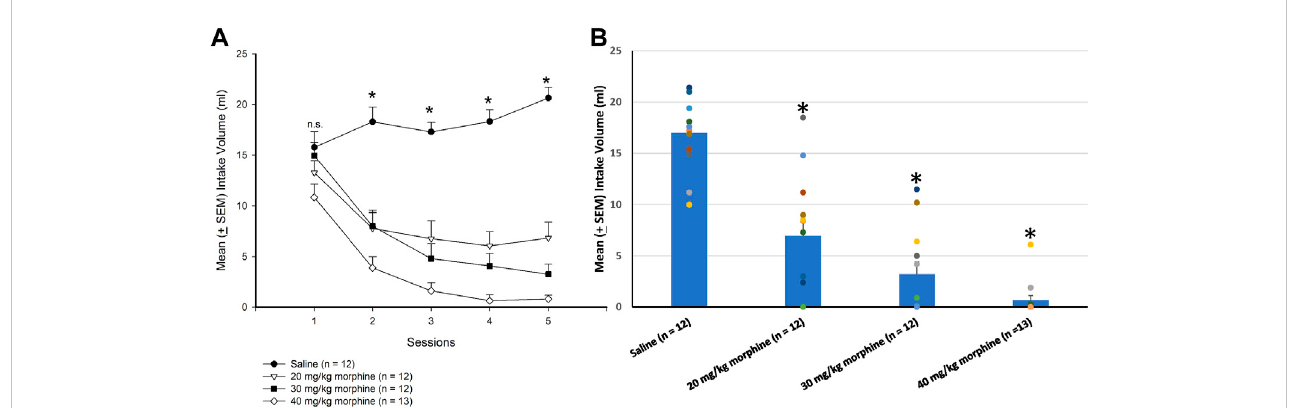
FIGURE 3 Morphine, the unconditioned stimulus agent, was conditioned with 0.1% saccharin solution to produce conditioned taste aversion (CTA). (A) Sessions 1 – 5 and (B) session 6 (in the testing phase) show the mean (±SEM) intake volume of 0.1% saccharin solution in rats injected with saline ( n = 12) or with